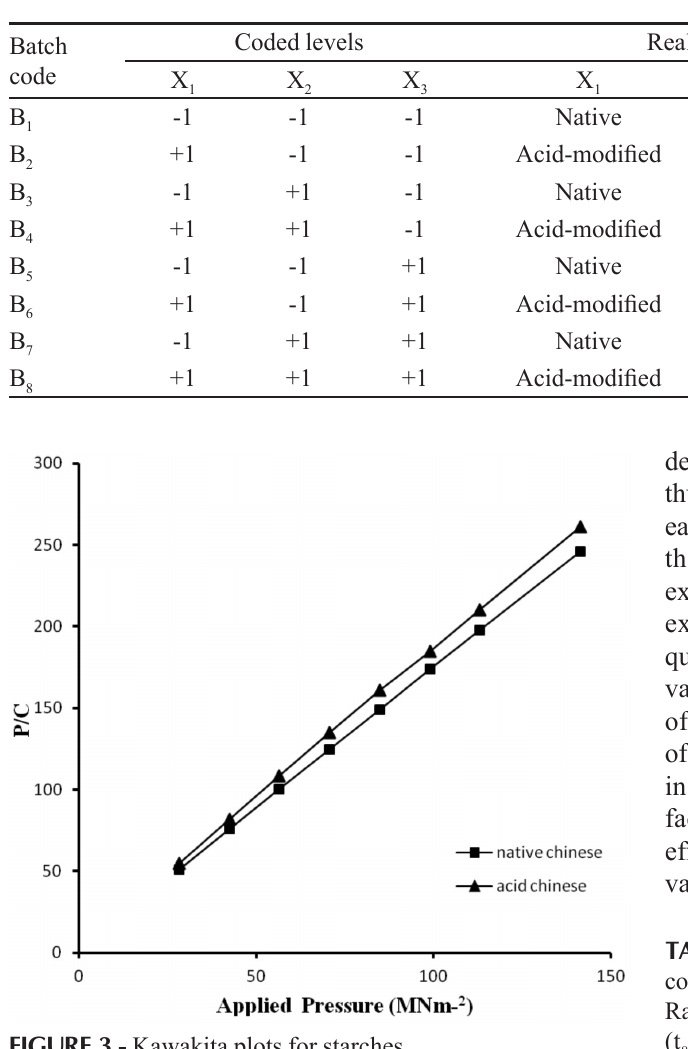
FIGURE 3 - Kawakita plots for starches.